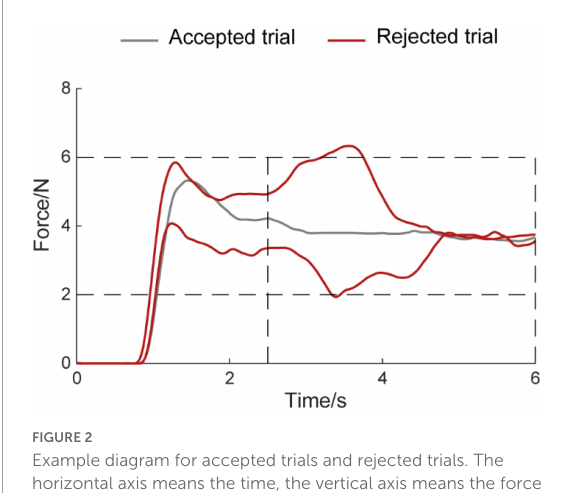
FIGURE2 Example diagram for accepted trials and rejected trials. The horizontal axis means the time, the vertical axis means the force amplitude. The Gray line means accepted trial, the red line means rejected